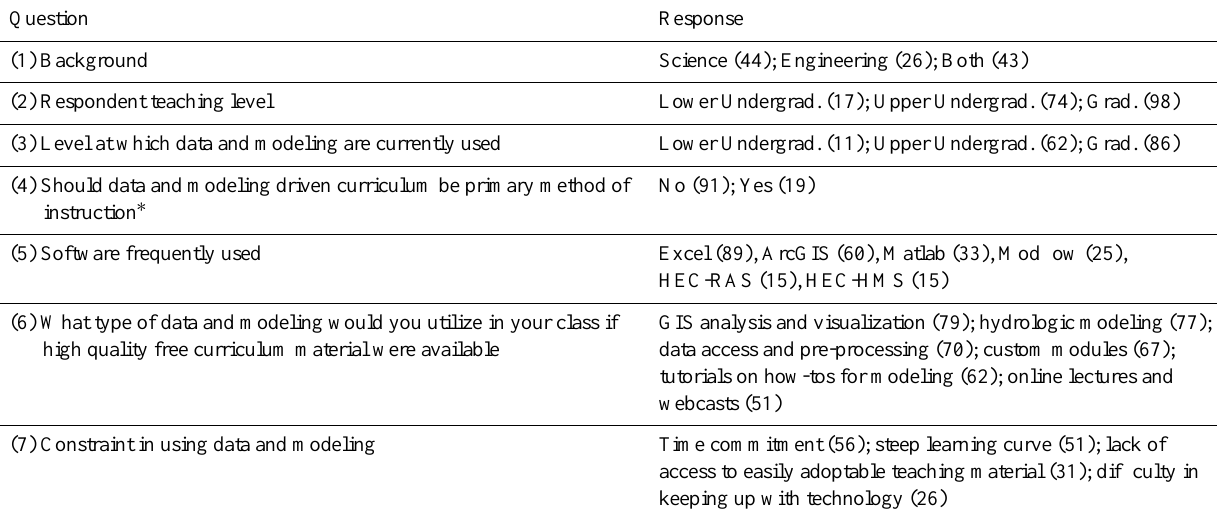
Table 1. Summarized results of the 2010 CUAHSI community survey on cyberlearning and data and modeling driven curriculum for the university hydrology